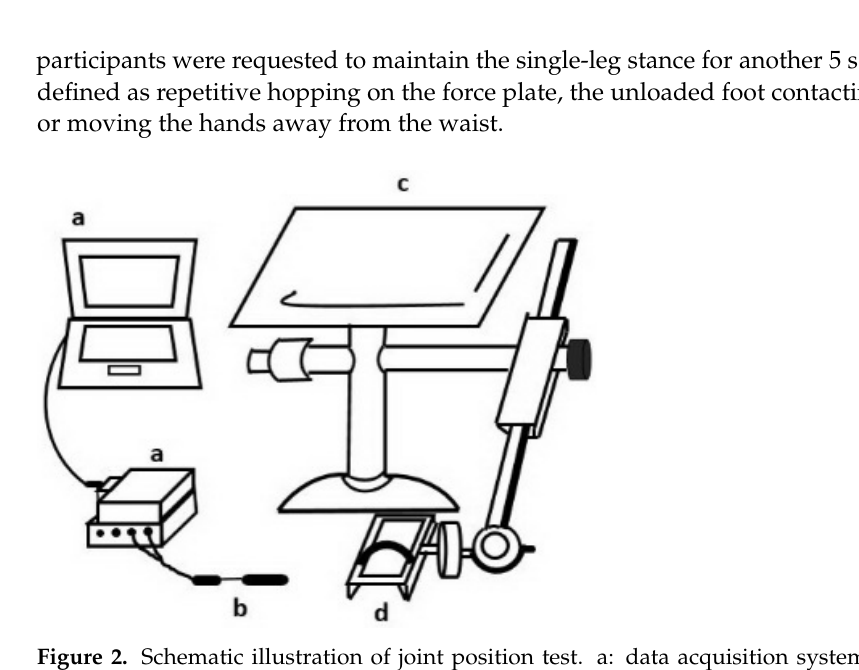
Figure 2. Schematic illustration of joint position test. a: data acquisition system; b: a two-axis electrogoniometer; c: custom-made chair and instrument; d: footplate.